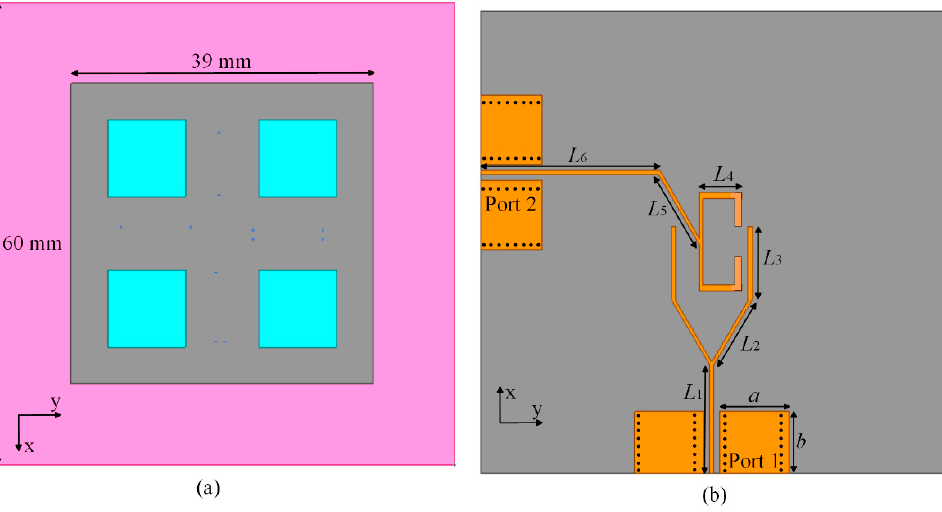
Figure 7. ( a ) Top view of the proposed dual-polarized antenna. ( b ) Back-side view of the proposed dual-polarized antenna.